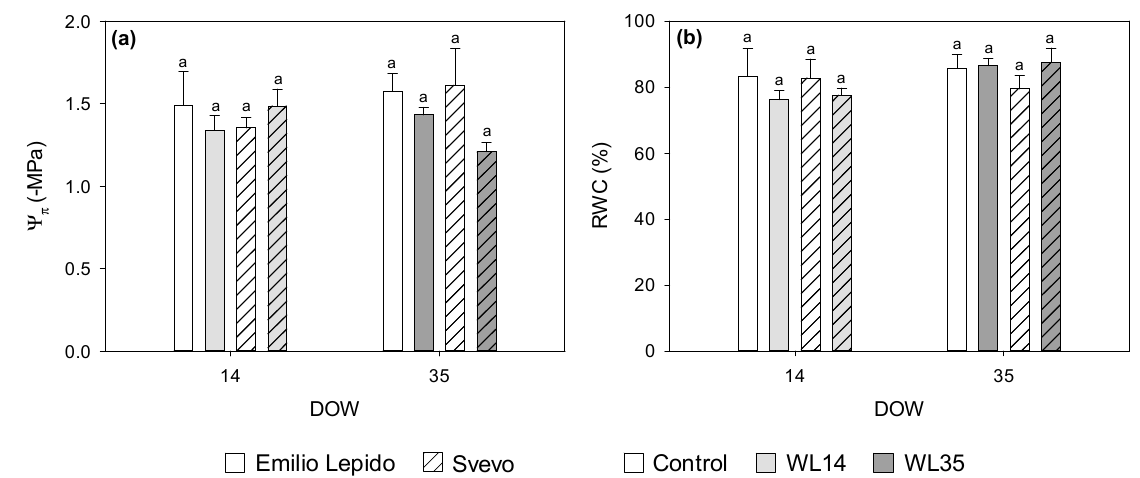
Figure 3. ( a ) Leaf osmotic potential ( Ψ π ), and ( b ) leaf relative water content (RWC) of the durum wheat cultivars Emilio Lepido (solid) and Svevo (pattern) subjected to 0 (i.e., control; white), 14 (i.e., WL14; light gray), or 35 (i.e., WL35; dark gray) days of waterlogging (DOW). Data are mean ± standard deviation. For each waterlogging duration, according to Tukey’s post hoc test ( p ≤ 0.05), different letters indicate significant differences among means ( p ≤ 0.05).